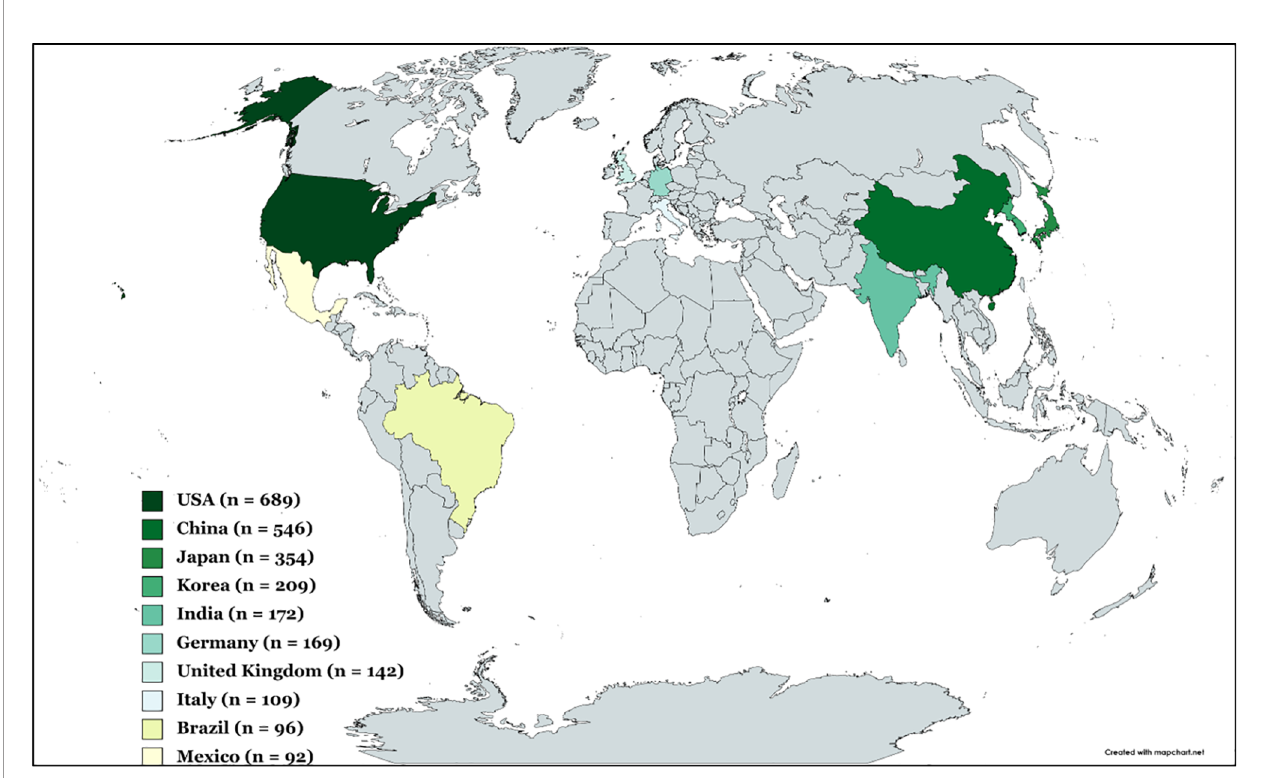
FIGURE 3 | Heat map of the top 10 leading countries based on capsaicin publications from 2001 to 2021. Grey colour shadings signify countries outside the top